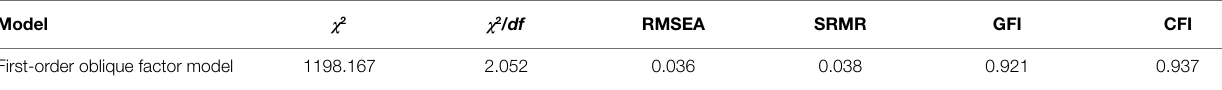
TABLE 3 | Fit index of first-order oblique factor model.